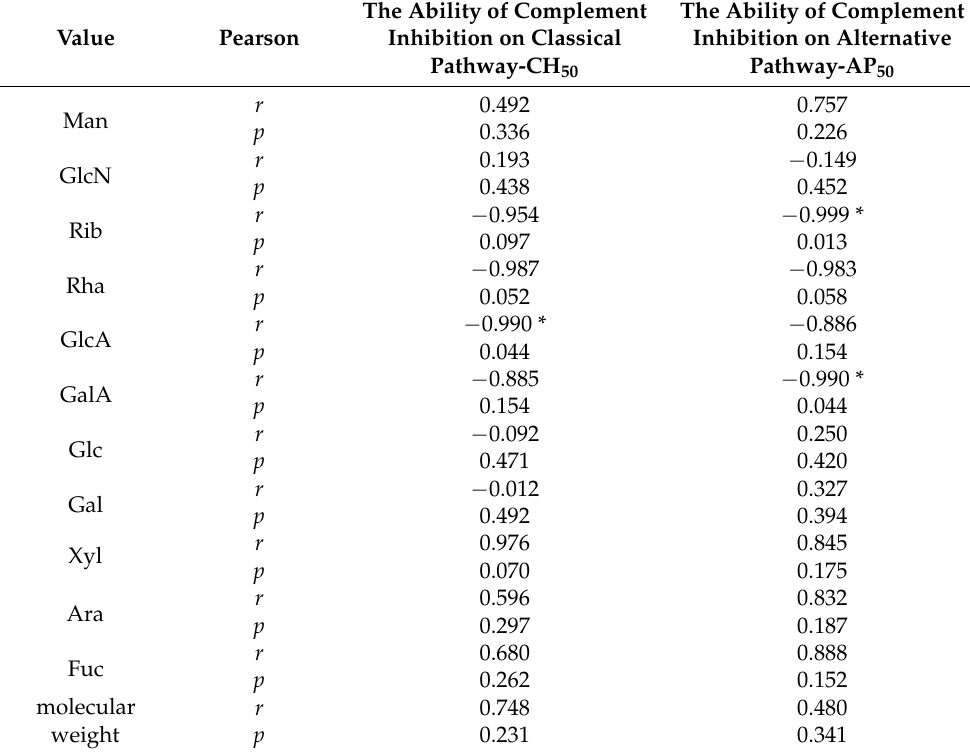
Table 3. Pearson correlation analysis of monosaccharide composition, molecular weight and anti- complementary activity of CMPs.